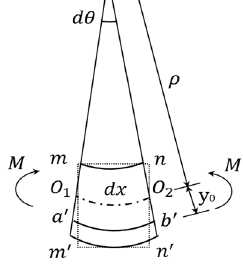
Figure 8. Pure curved structure deformation.